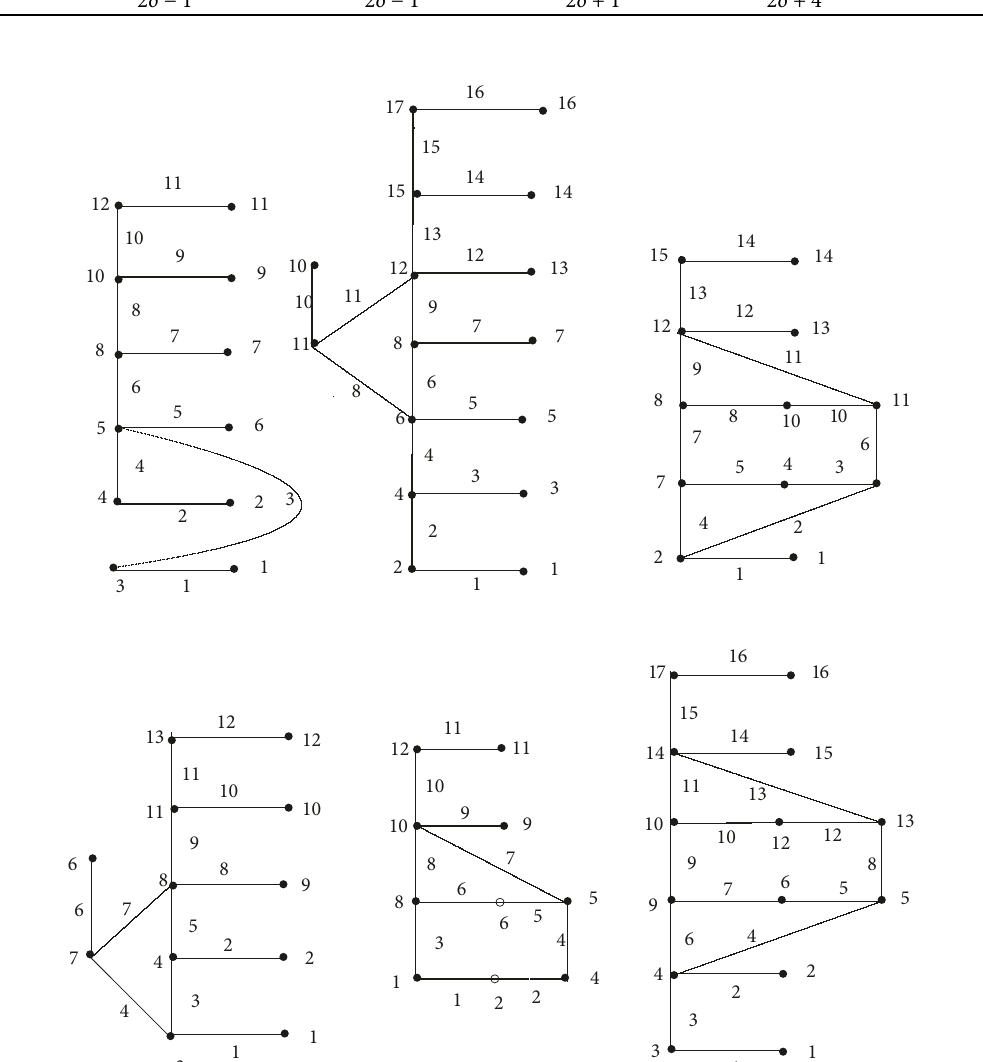
Figure 3: A classical mean labeling of G obtained by duplicating an edge of a graph P